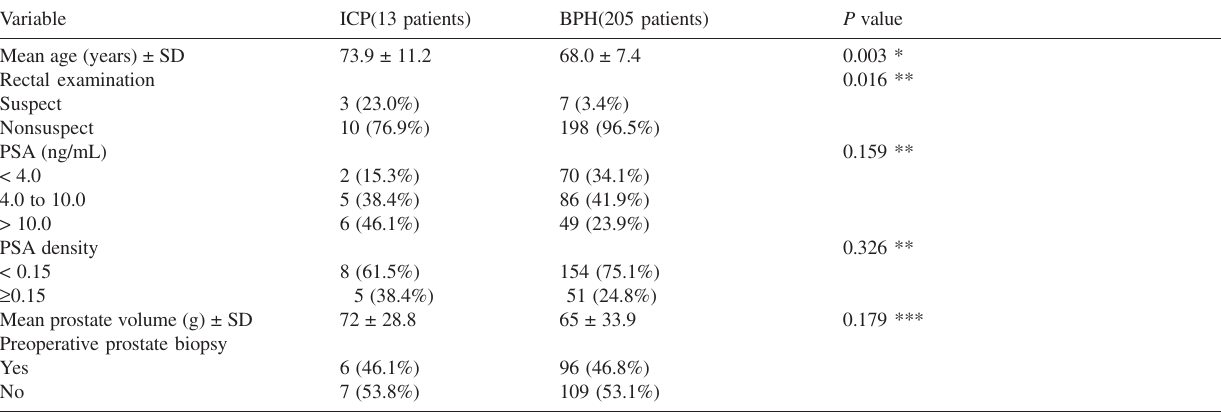
Table 3 - Risk factors for diagnosis of Characteristics of patients with stage T1b incidental prostate cancer (ICP)